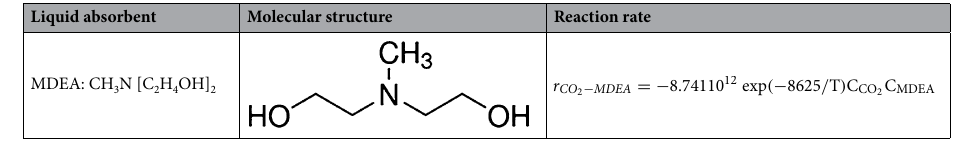
Table 4. The reaction rate between CO 2 —MDEA 34 .